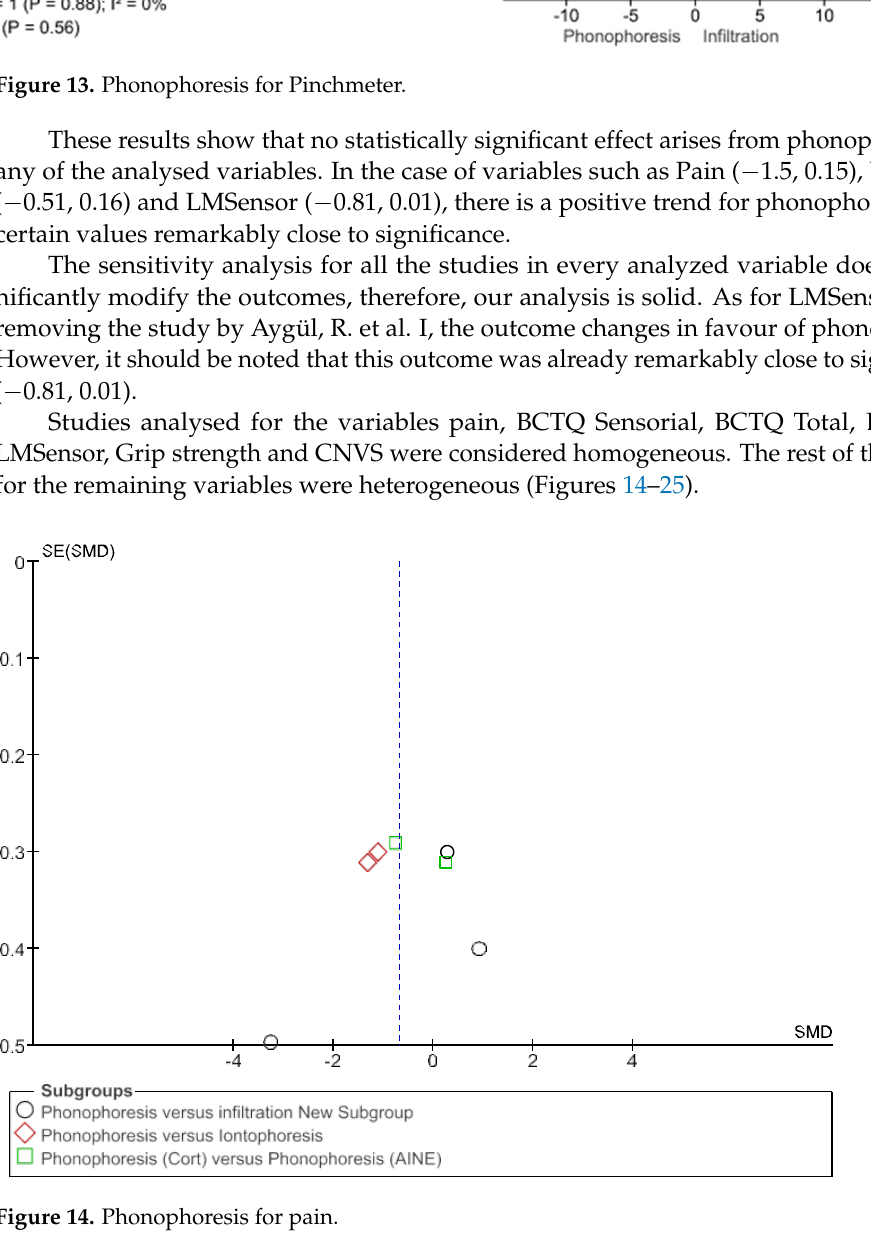
Figure 13. Phonophoresis for Pinchmeter.